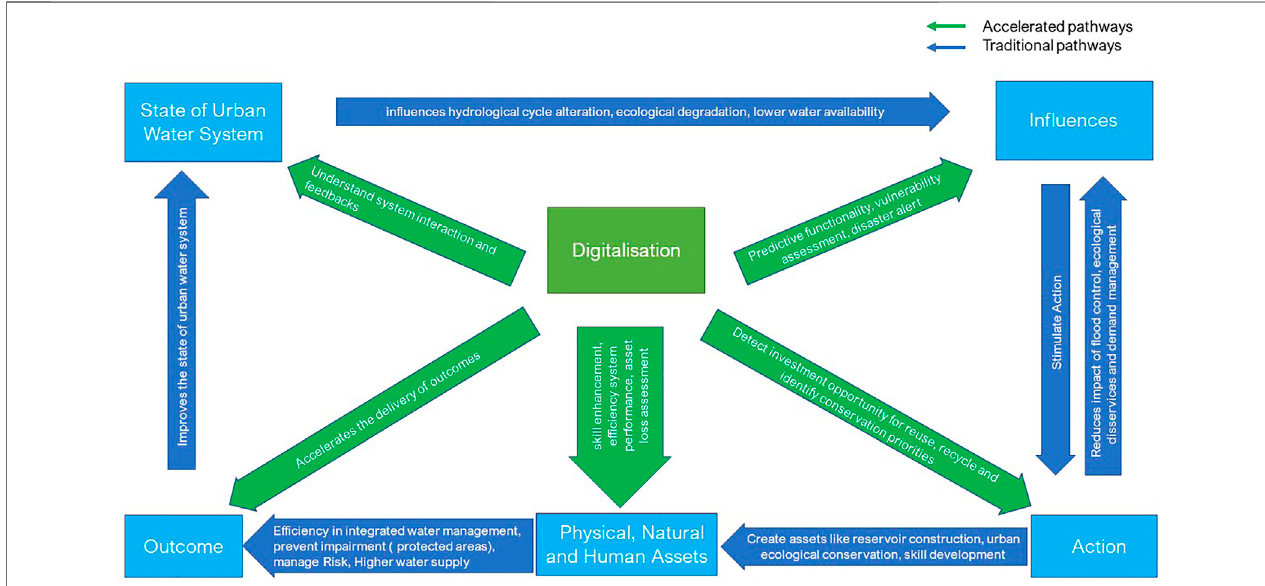
FIGURE 1 | A conceptual framework showing how digitalization can provide alternate accelerated pathways to the traditional development pathways.